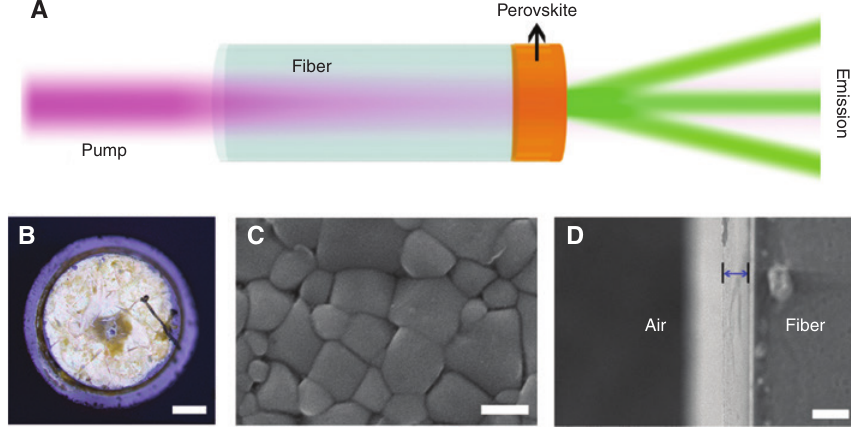
Figure 1: Demonstration of a perovskite random laser on the fiber tip. (A) Schematic diagram of a perovskite random laser on a fiber facet. (B) Microphotograph of the perovskite random laser on the fiber facet. The scale bar is 200 μ m. (C) SEM image of the perovskite film on the end face of the fiber. The scale bar is 500 nm. (D) Side-view SEM image of the perovskite random laser on the fiber facet. The scale bar is 10 μ